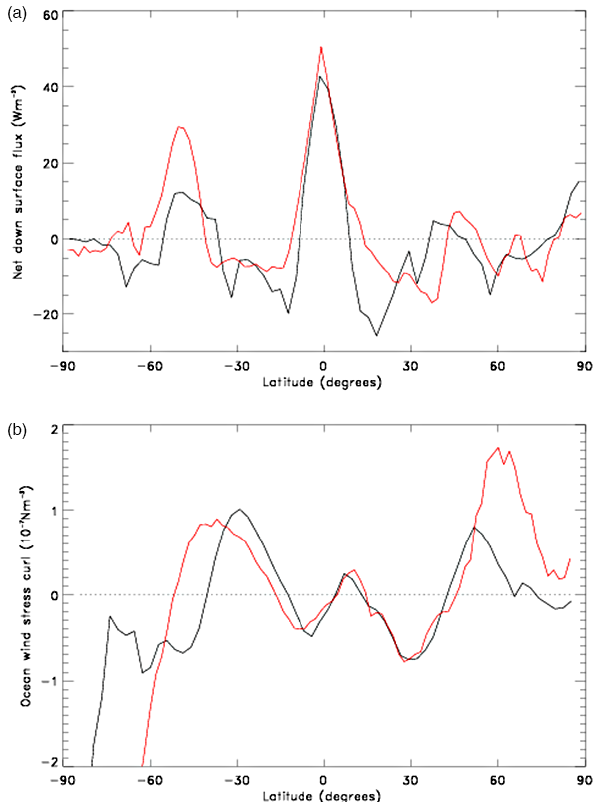
Figure 11. Annually averaged net downward zonal surface energy imbalance (Wm − 2 ) in IGCM4 (black) and NCEP reanalysis (red, a ); wind stress curl (10 − 7 Nm − 3 ) in IGCM4 (black) and NCEP re- analysis (red, b